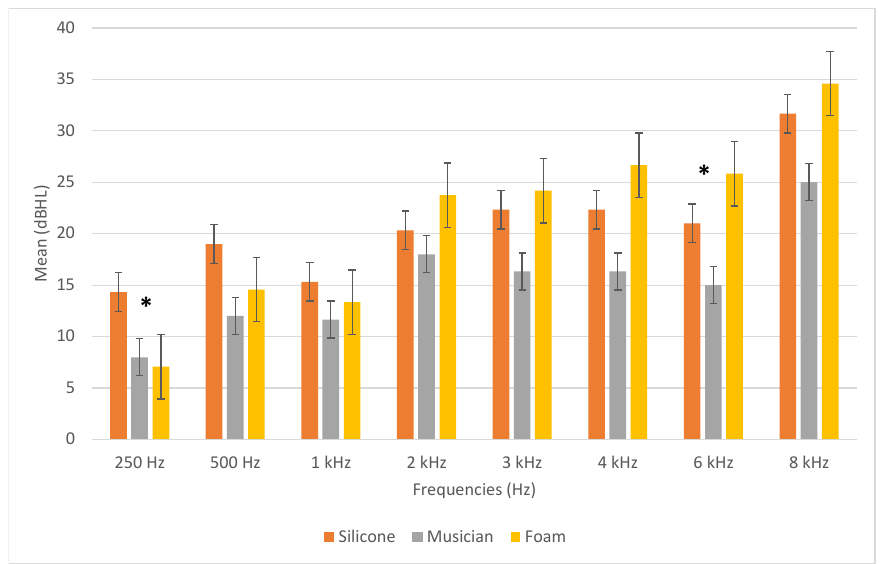
Figure 2. Mean HPD attenuation values with REAT. Legend: HPD: hearing protection device; REAT: real-ear attenuation at threshold; dBHL: decibels hearing level. * significant (250 Hz— p = 0.012; 6 kHz— p = 0.048).